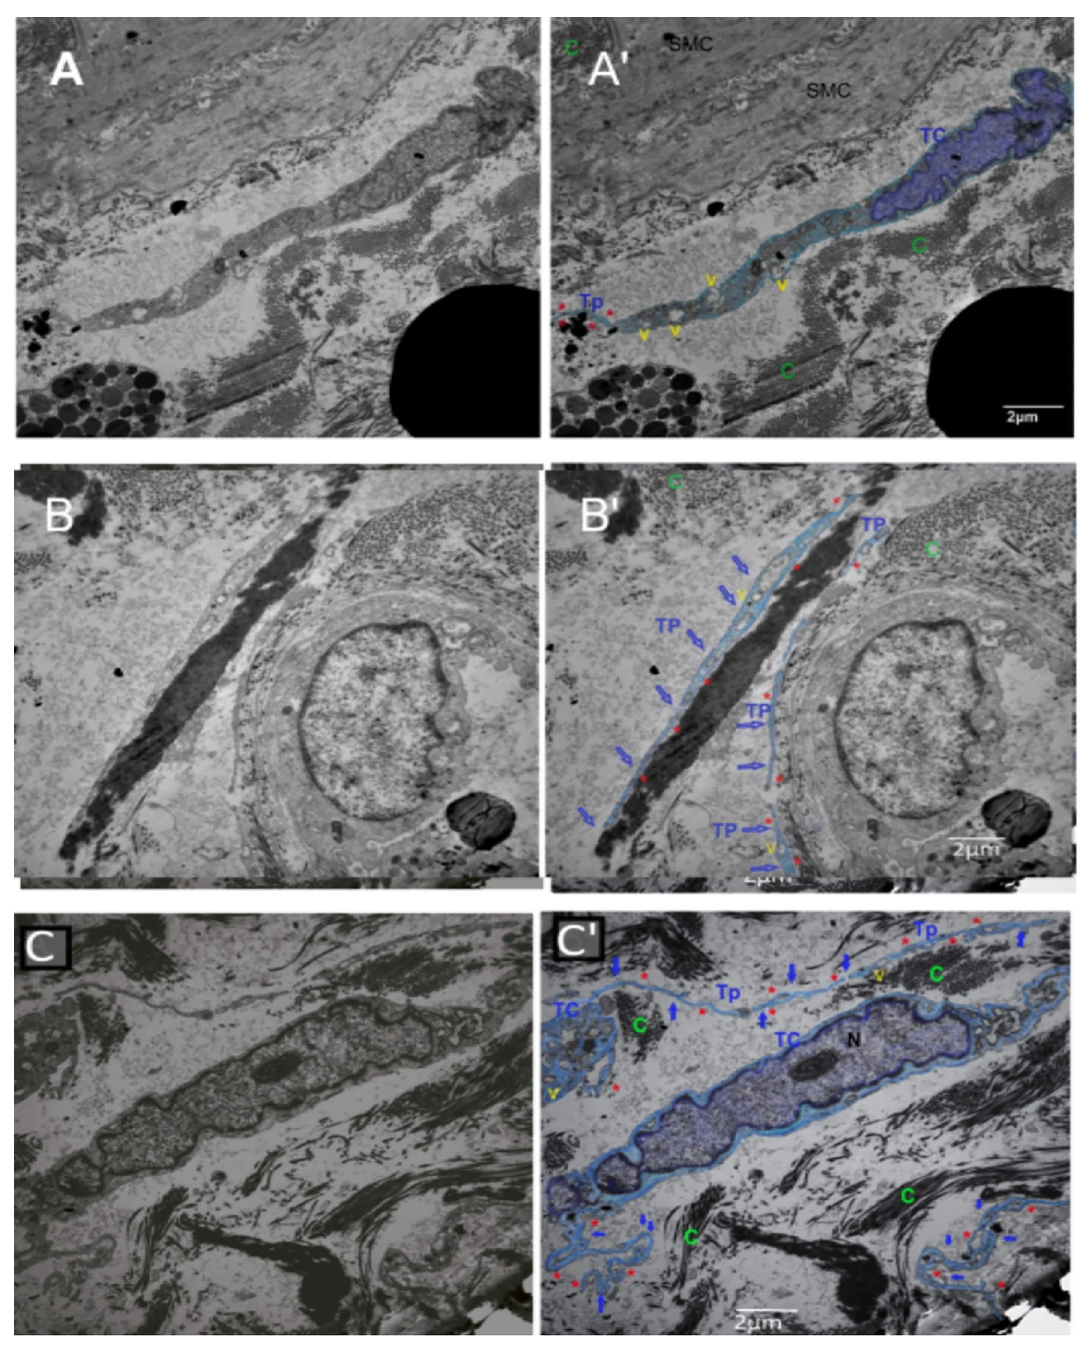
Figure 3. TEM microgram of submucosa and muscularis propria of normal-appearing tissue of urinary bladder with MIBC. (A,A ′ ) (A: original findings), (A’: digitalized image) showing TC (TC colored light blue), TC nucleus (colored violet) with distinctive cytoplasm containing numerous vesicles (yellow V), and Tps (Tp red Asterix). TCs and Tps are infiltrating between smooth muscle cells (SMC) and dense collagen (green C). (B,B ′ ) (B: original findings), (B’: digitalized image) showing Tp (colored light blue, pointed with short blue arrows, they have many vesicles (yellow V), and three Tp are in close contact with blood vessels. (C,C ′ ) ( C : original findings), ( C ′ : digitalized image) showing two TC cells (colored light blue) with a distinctive nucleus in one of them (N), network of Tps appearing numerous, branching, and arborizing (small blue arrows and red Asterix), Tps cytoplasm are rich in vesicles (yellow V), TCs and Tps are infiltrating dense collection of collagens (green C). (Scale bar 2